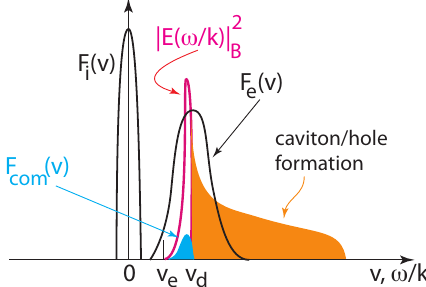
Figure 3. Phase space of Buneman modes excited with spectrum | E(ω/k) | 2 and wave number k = ω e /v d evolving at phase veloci- b ties above v e for u ≡ v d > v e . The spectrum is very narrow in phase velocity. The electron pair distribution function F com (v) produced (blue) has similar width as the spectrum and is thus much colder than the original electron distribution. In caviton formation the spec- trum extends to much larger phase velocities which, however, has no remarkable effect on the pair